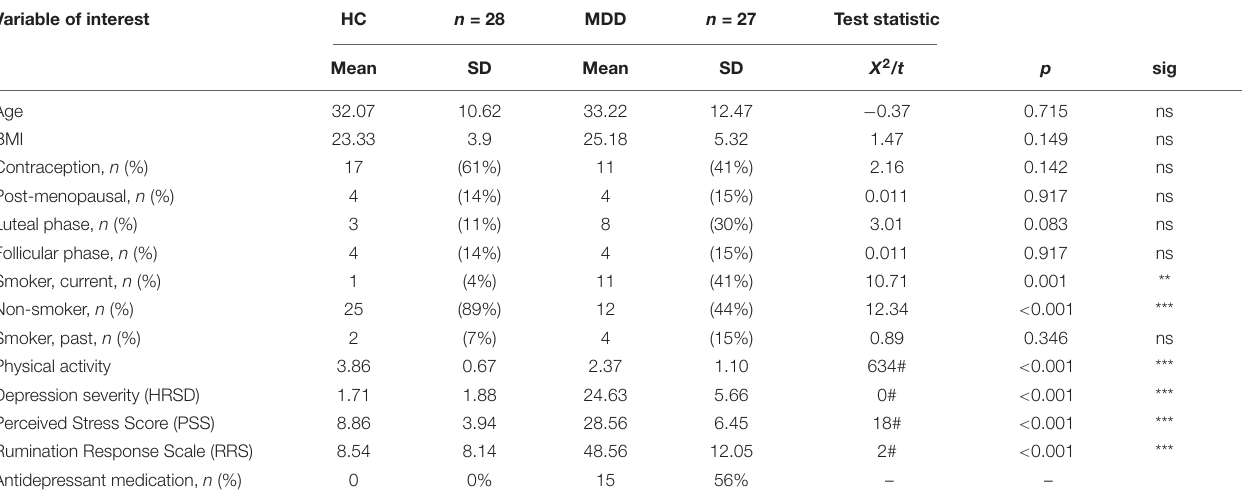
TABLE 1 | Demographic data and statistical comparison.